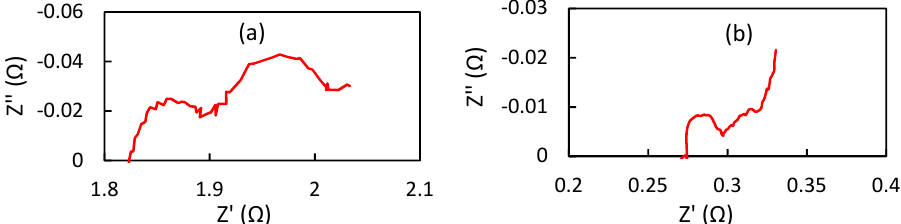
Figure 6. Single battery cell Nyquist figure. ( a ) AC impedance results of untreated electrode, ( b ) AC impedance results of the treated electrode.